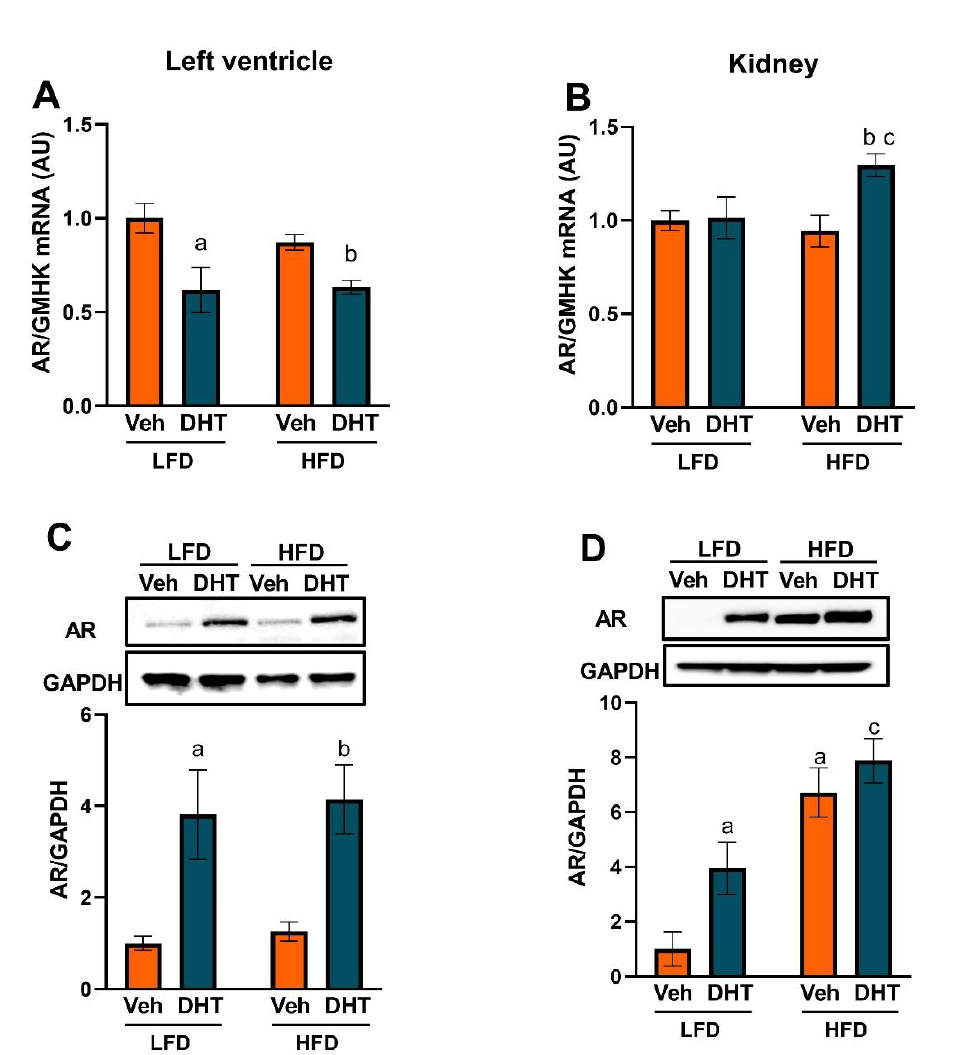
Figure 2. Effect of DHT and diet on androgen receptor mRNA and protein expression. Animals were treated with dihydrotestosterone (DHT) or vehicle (Veh) and maintained in low (LFD) or high (HFD) fat diet for 90 days. Left ventricle (LV) ( A ) and kidney ( B ) Androgen receptor (AR) mRNA was quantified by RT-qPCR ( N = 6–8/group). LV ( C ) and kidney ( D ) AR protein was quantified by Western-blot ( N = 4/group). Data are expressed as mean ± SEM. Data were analyzed by two-way ANOVA followed by Fisher’s LSD test. a p < 0.05 vs. LFD-Veh; b p < 0.05 vs. HFD-Veh; c p < 0.05 vs. LFD-DHT.